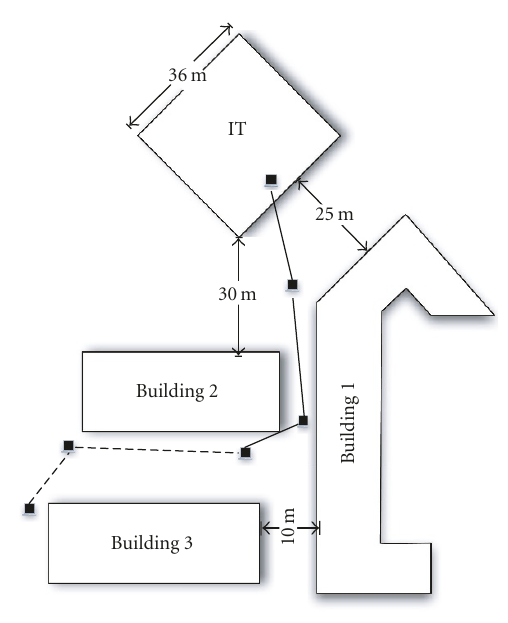
Figure 7: Topology of the outdoor